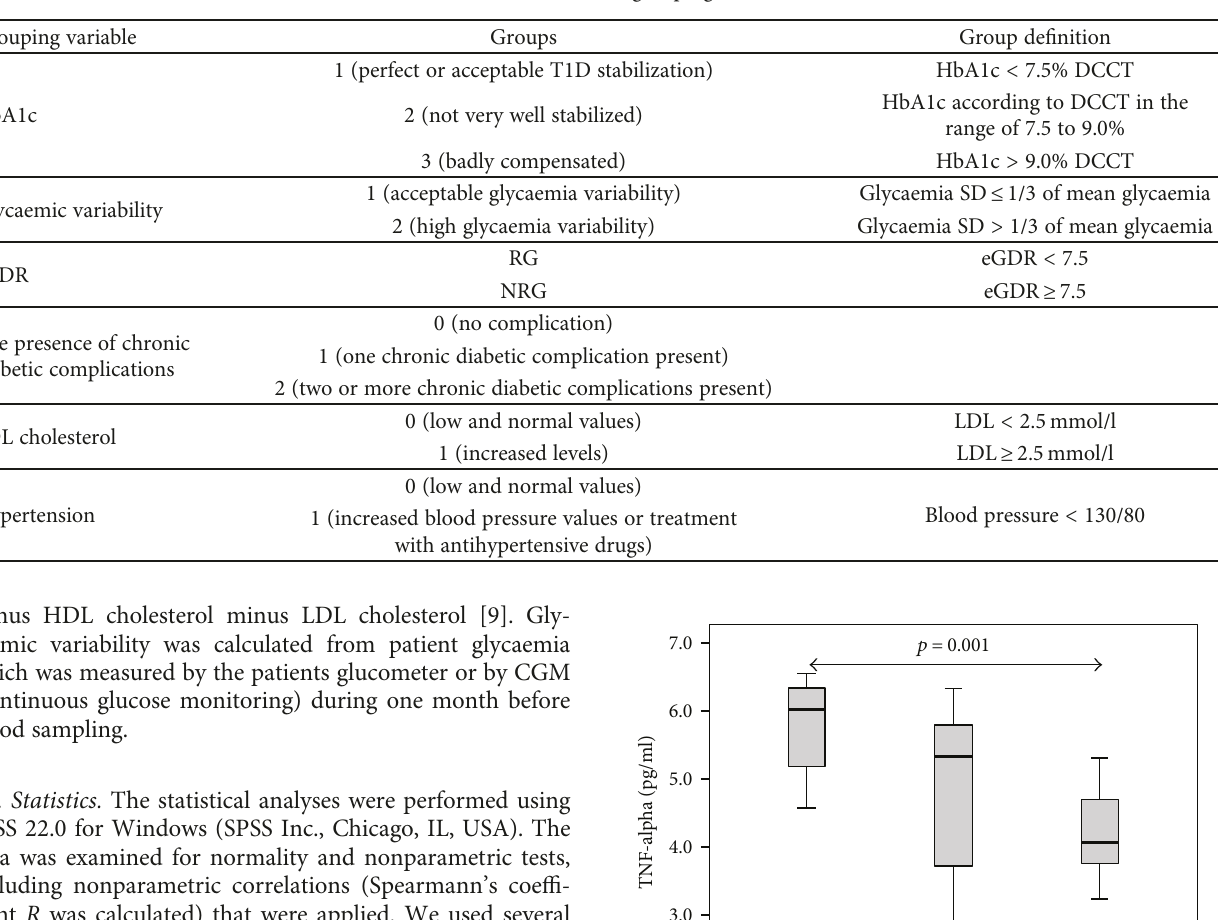
Table 2: De fi nitions of the grouping variables.